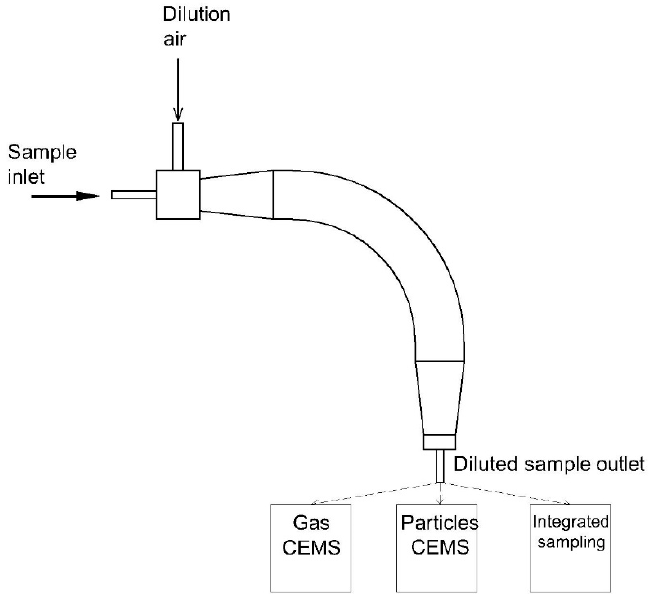
Figure 12. A Schematic of the multipollutant dilution system [113–115].